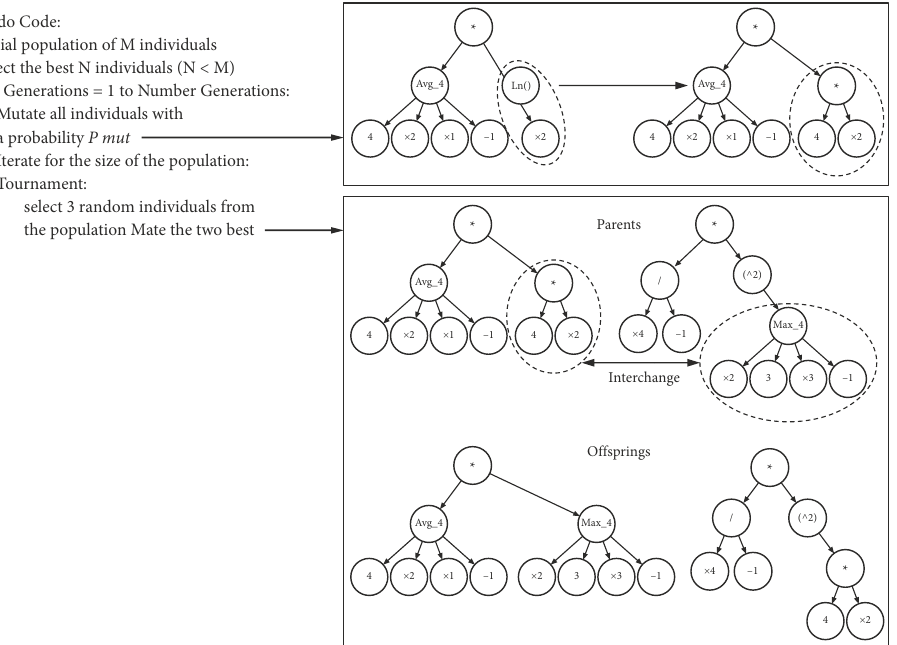
Figure 1. Experimental setup – Design of the GP